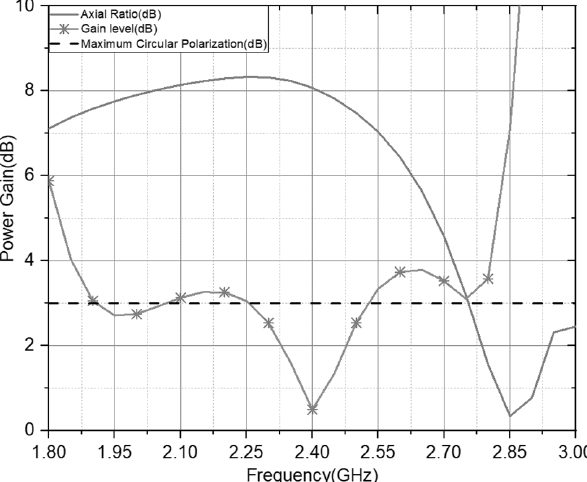
Figure 11. Power Gain level and Axial Ratio of the Double U slot with the dual feed CP Antenna.